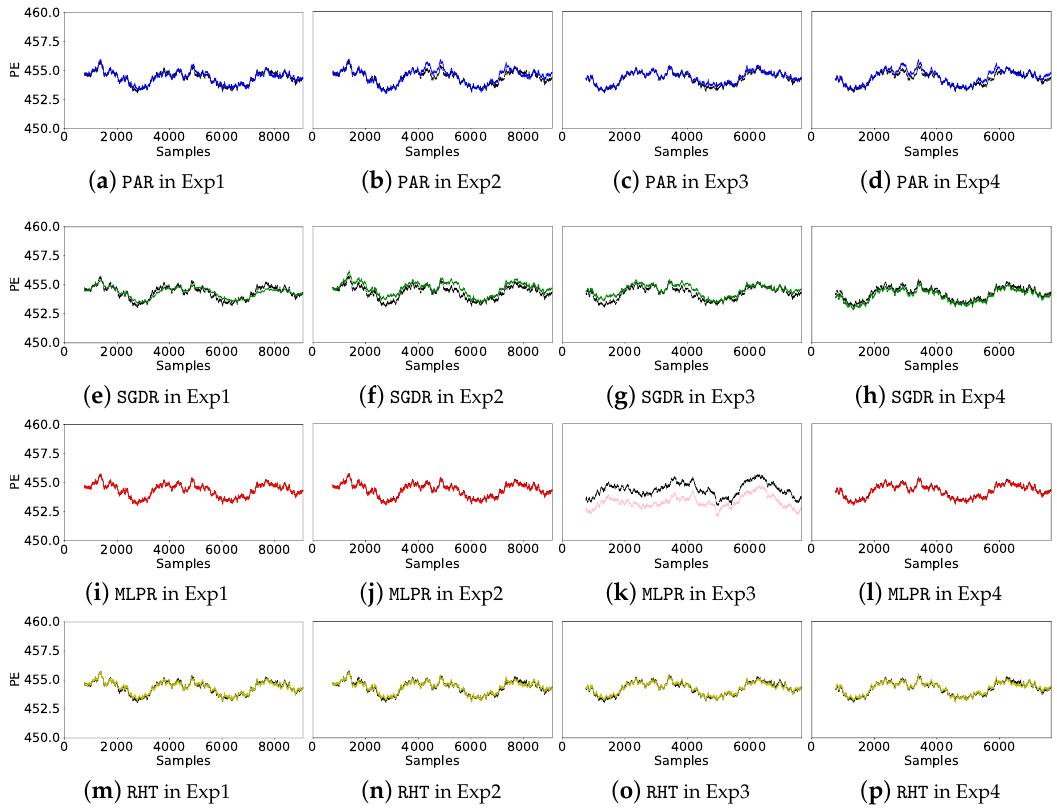
Figure 8. Real (black line) and predicted (colored line) PEs of PAR , SGDR , MLPR and RHT for run